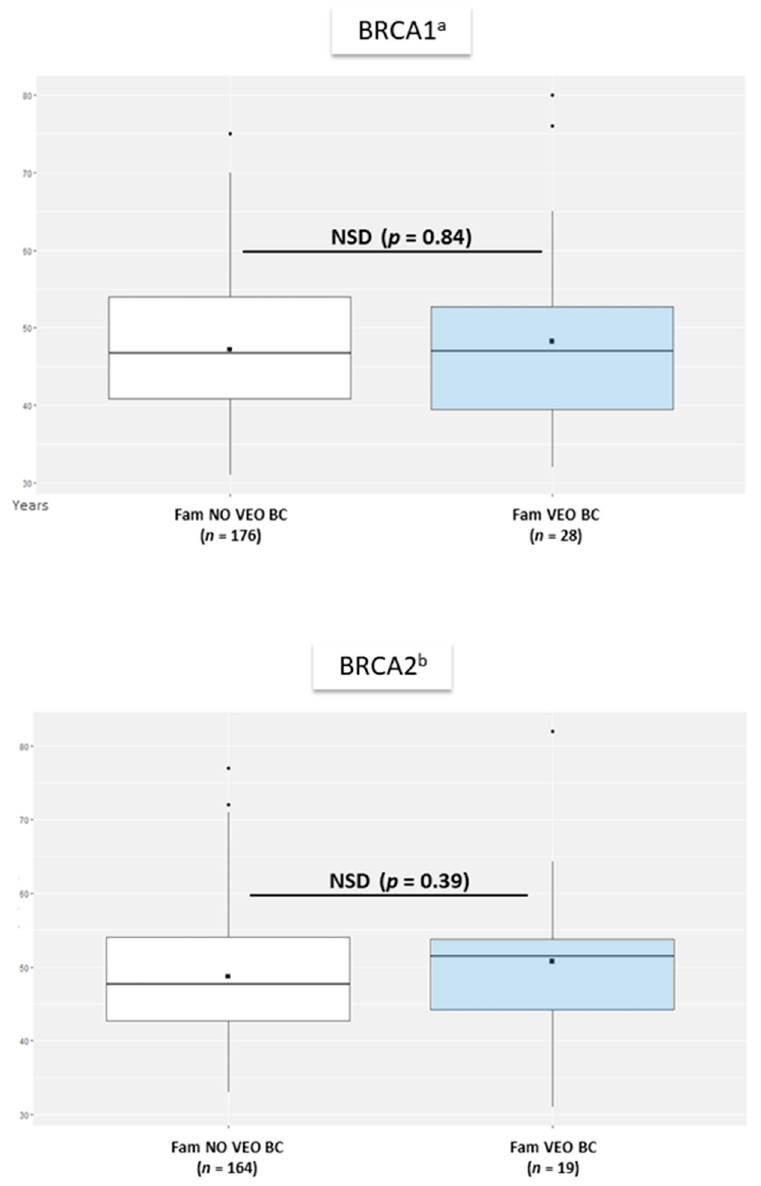
Figure 2. Average of mean age at BC diagnosis in female relatives of women with VEO-BC versus no VEO-BC. a : among BRCA1 mutation ( BRCA1m ) carrier women. b : among BRCA2m carrier women. Fam. VEO-BC: families with at least one VEO-BC. Fam. NO VEO-BC: Families without any VEO-BC. ( n ): number of families with available data for age at first BC diagnosis in women. NSD: nonsignificant difference (two-sided Wilcoxon–Mann–Withney test). Horizontal line is median, box edges are 1st and 3rd quartile and whiskers are range of age at diagnosis of BC in relatives in each family. Central black square is the mean average age at diagnosis of BC in relatives in each